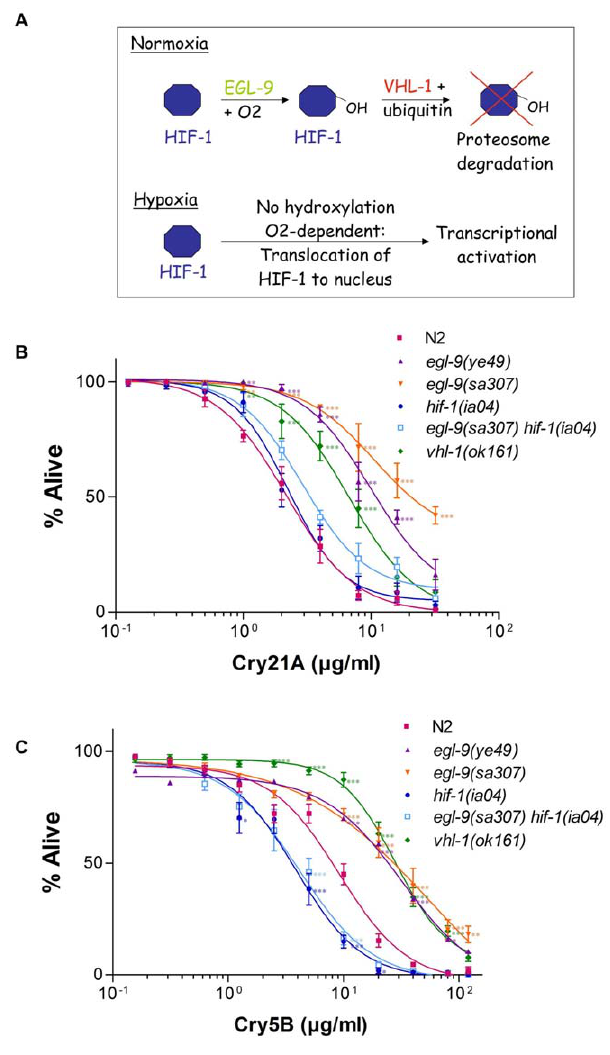
Figure 2. Quantitative response of egl-9 and HIF-1 pathway mutants to Cry PFTs. (A) Schematic illustrating O 2 -dependent regulation of HIF-1 activity. The O 2 -dependent prolyl hydroxylation of HIF-1 by EGL-9/PHD increases its affinity to VHL-1, leading to ubiquitylation and destruction. (B, C) Dose-dependent mortality assays were performed using (B) Cry21A spore crystal lysates or (C) purified Cry5B to quantitatively compare sensitivities of wild-type N2, egl-9 mutants, and HIF-1 pathway mutants to PFTs. Each data point shows the mean and standard errors of the mean of results from three independent experiments (three wells per experiment; on average, 180 animals per data point). Statistical differences between mutant strains and N2 are given for each concentration using P values represented by asterisks as follows: * P , 0.05; ** P , 0.01; *** P , 0.001. Percent alive at specific doses and LC 50 values are reported in Table